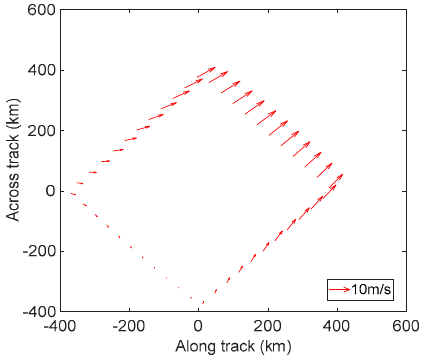
Figure 5. Linear wind field distribution at the location of the spaceborne radar beam footprint.